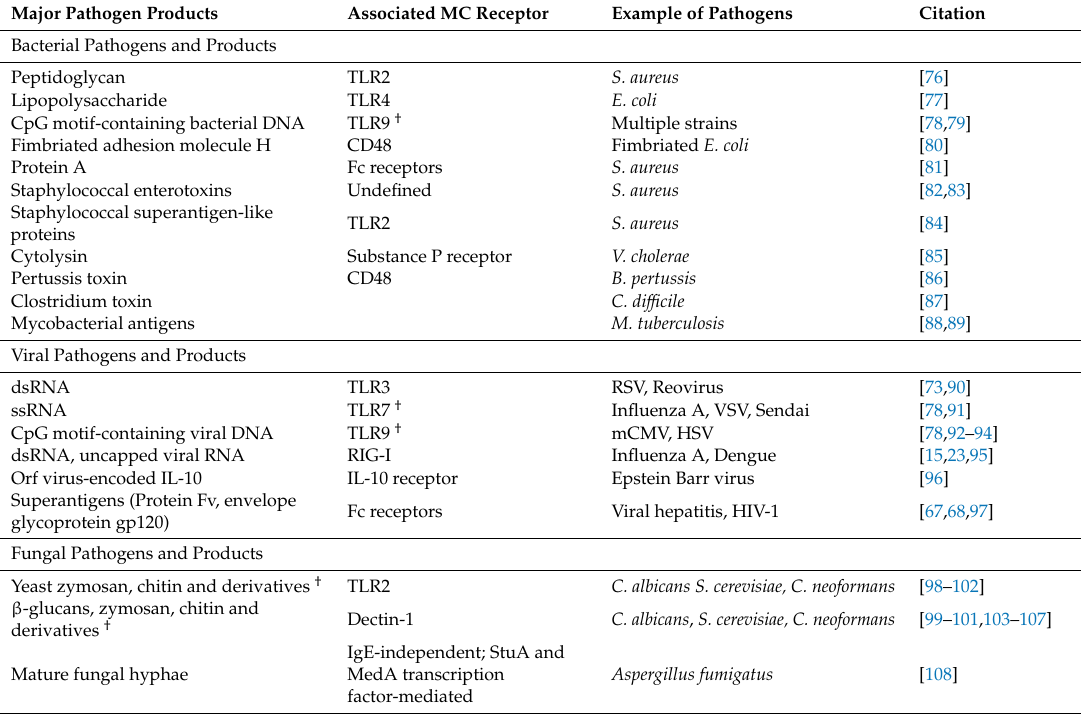
Table 3. Major classes of direct mast cell responses to pathogen